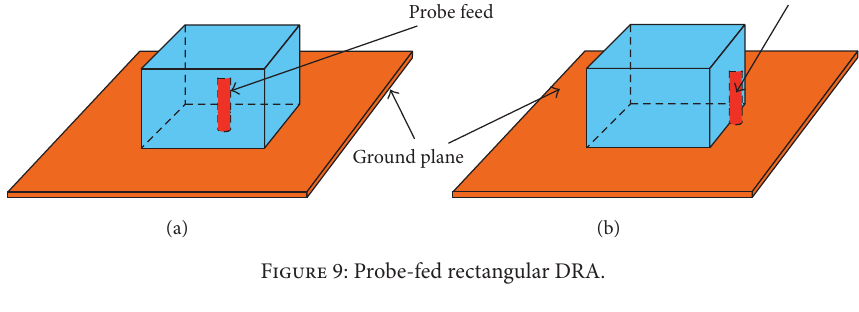
Figure 9: Probe-fed rectangular DRA.